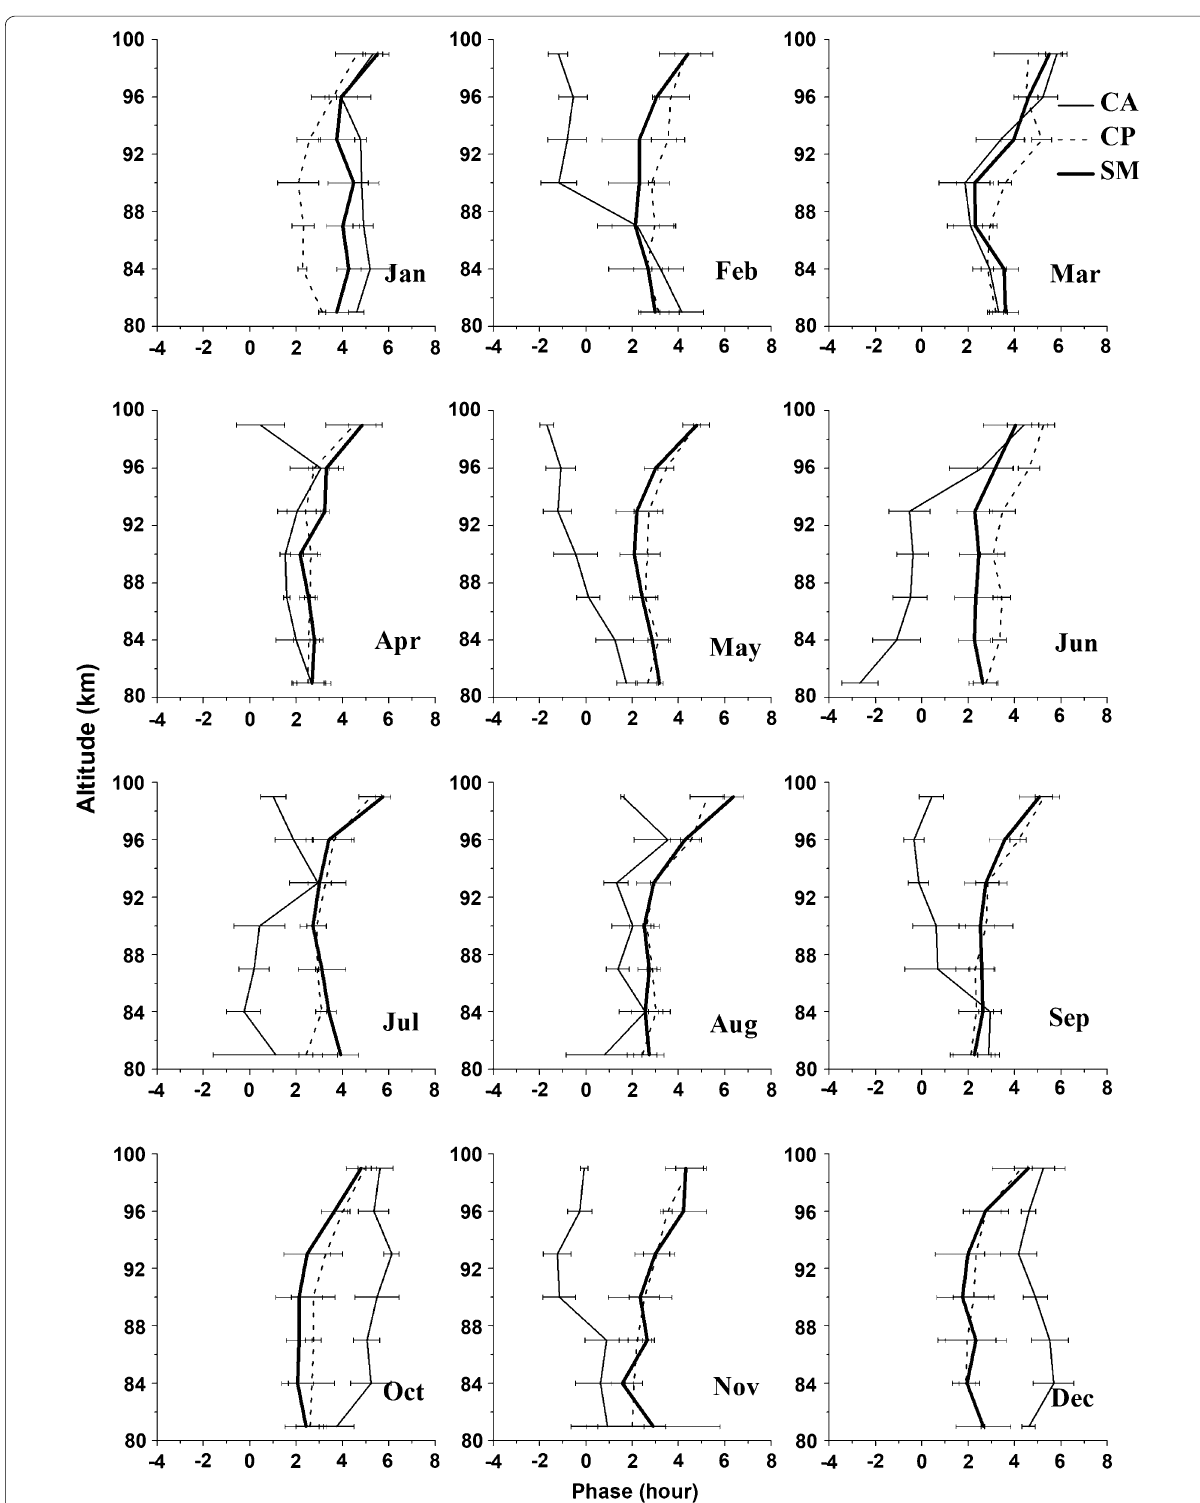
Fig. 8 Monthly mean phase of the QDT in the MLT at CA (thin line), CP (dotted line) and SM (bold line) over various months of the year in the zonal wind. The horizontal bars represent the